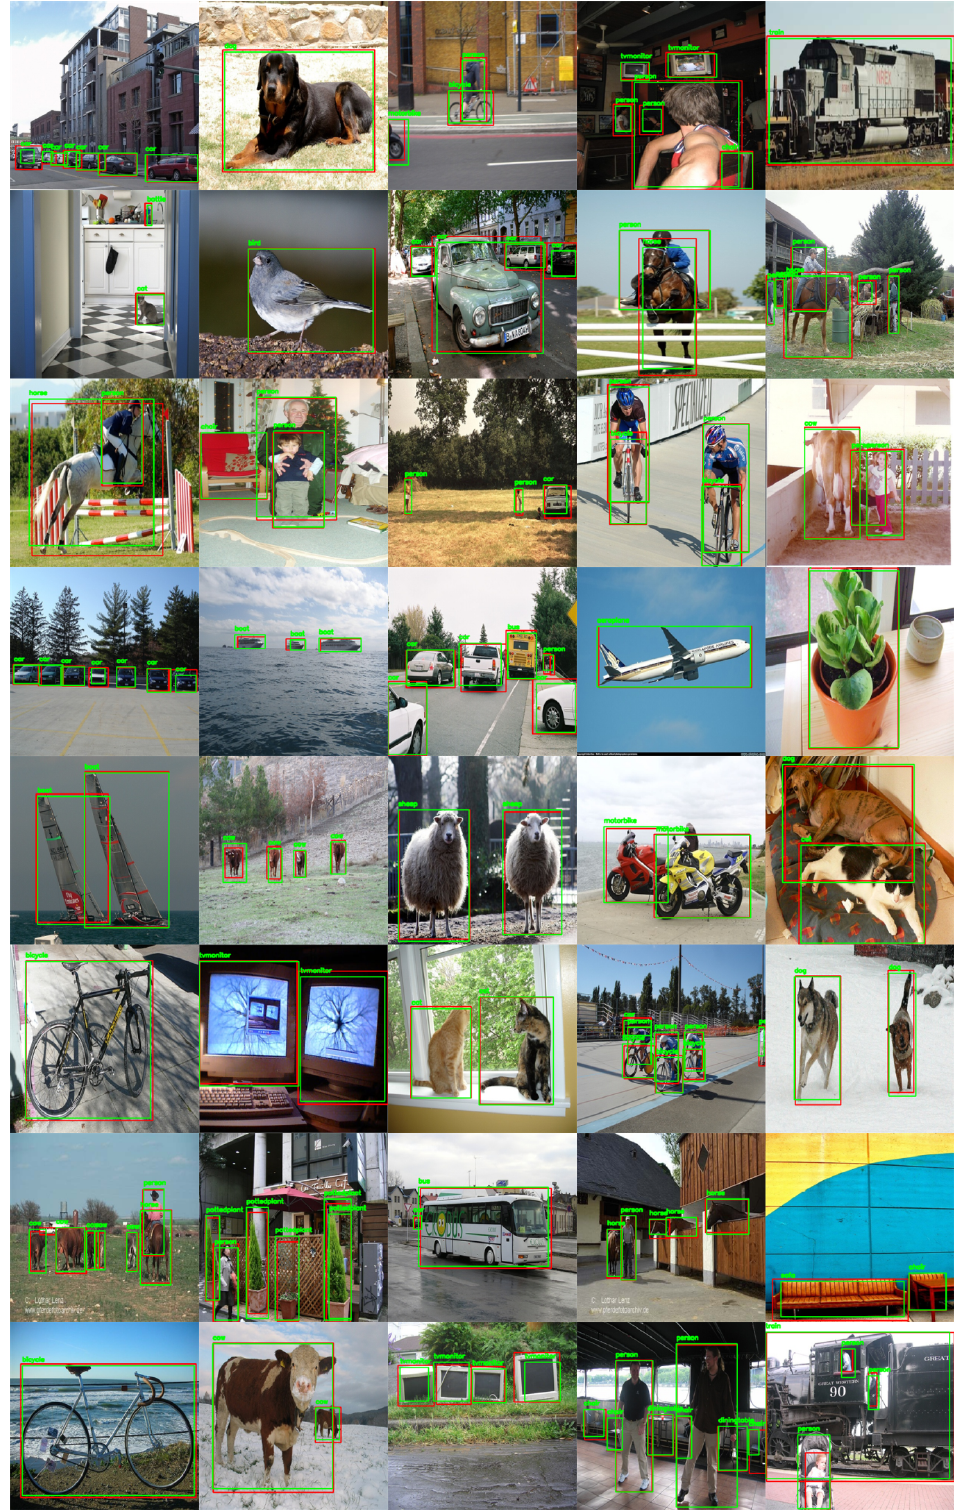
Figure 8. Sample results obtained by the proposed method on random images from PASCAL VOC2007 test set. The green and red bounding boxes refer to the detection and ground truth boxes,